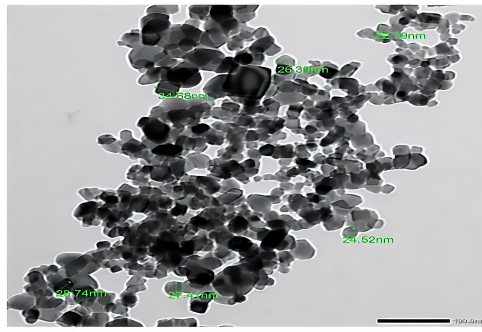
Figure 2: Transmission electron microscopy of TiO 2 - NPs ( JEM-1400 Plus, SA-MAG X